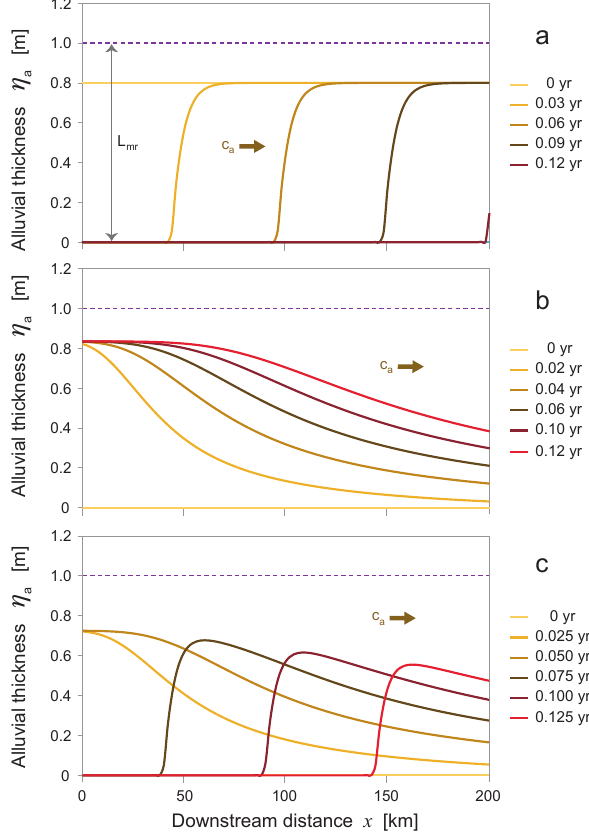
Figure 12. MRSAA model solutions for (a) stripping of an allu- vial layer to bare bedrock, (b) emplacement of an alluvial cover over initially bare bedrock and (c) evolution of a pulse of sediment over bare bedrock. Numerical simulations of the evolution of allu- vial thickness η a (x, t) over streamwise distance x are shown for a series of time steps t as indicated in the